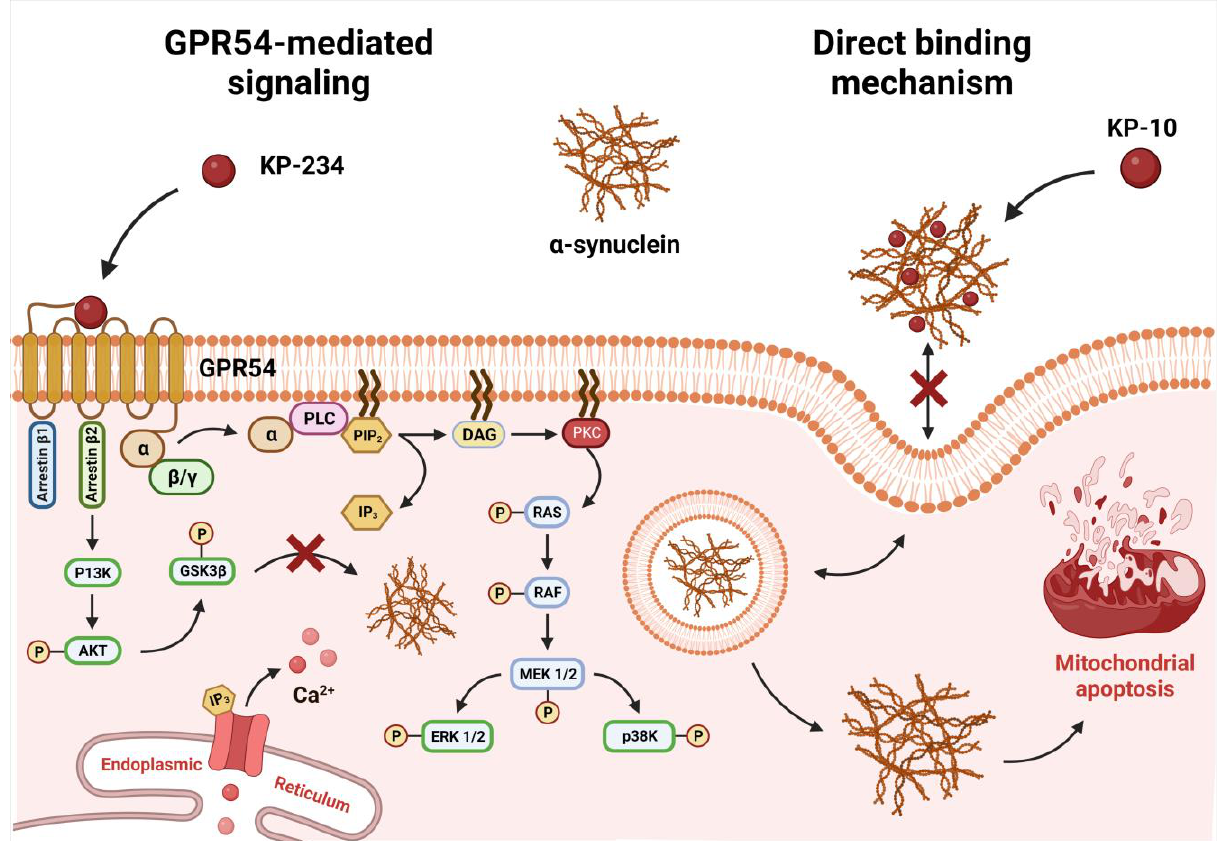
Figure 4. Hypothetical model depicting KP-10′s mode of protection in ChAT-positive neurons. A multi-hit hypothesis was proposed for KP-10′s alleviation of human wild-type and E46K mutant α-syn-induced neuronal death in ChAT-positive neurons, suggesting a direct-binding extracellular mechanism that directly or indirectly modulates ChAT expression levels. Supporting this notion, the pharmacological blockade of GPR54 with KP-234 had no influence on KP-10′s salutary effects.